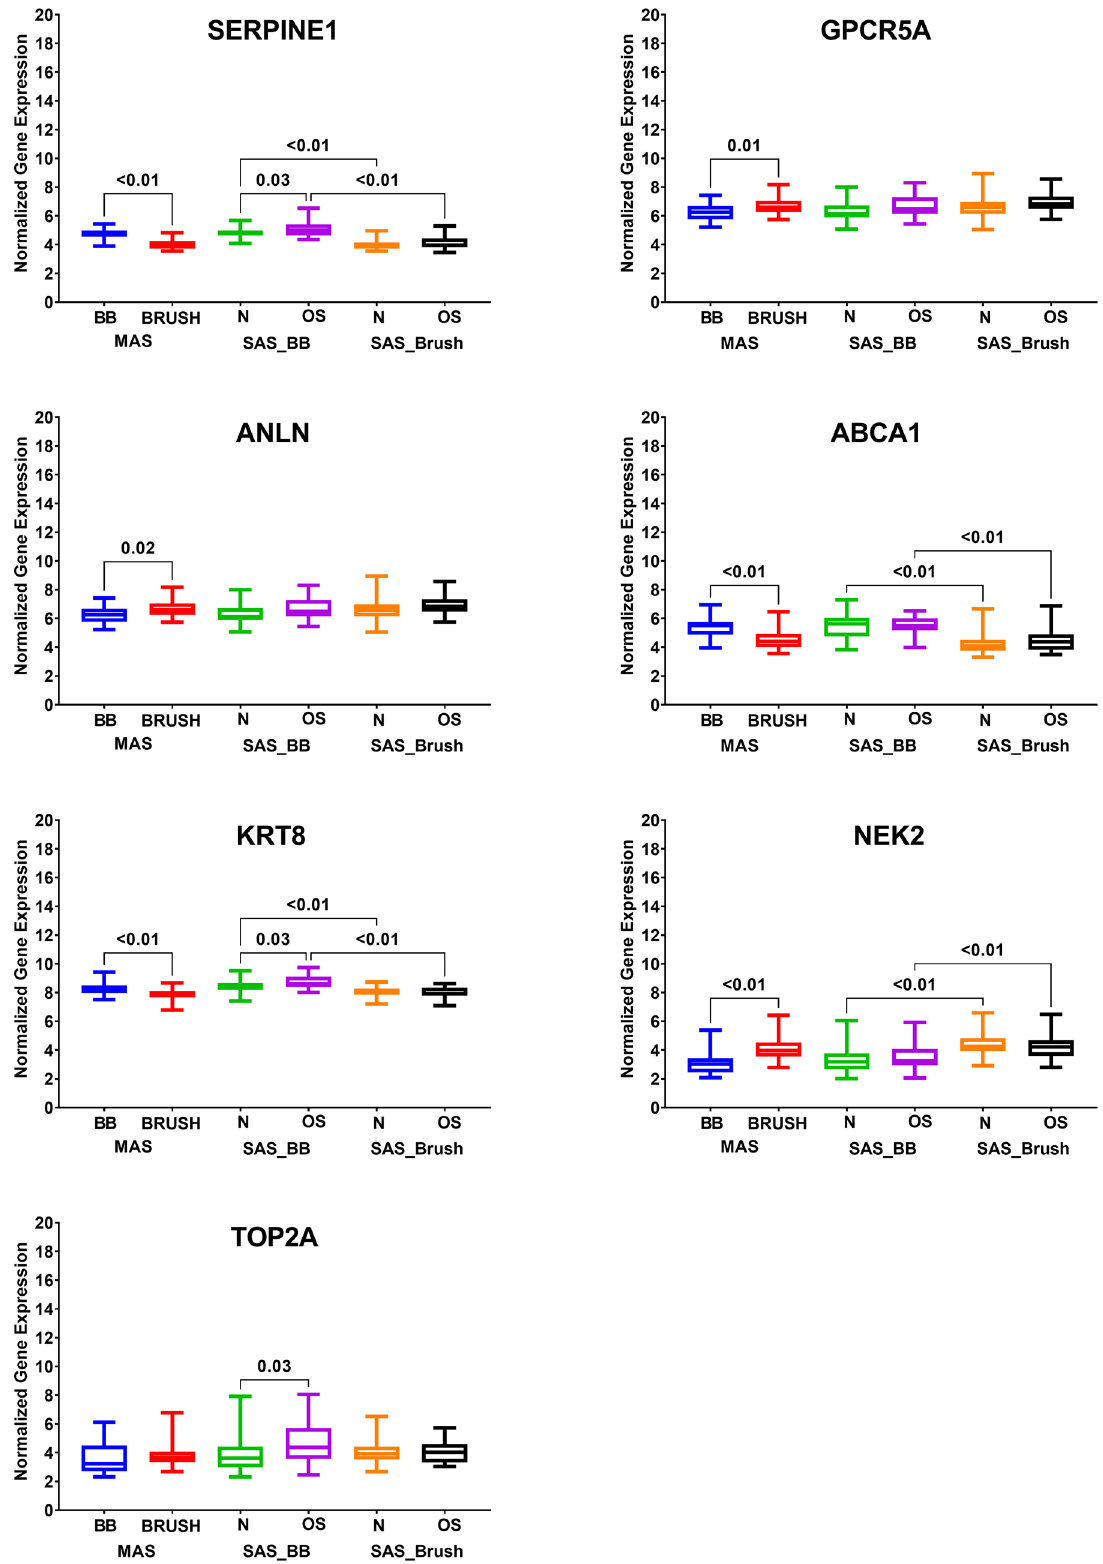
Figure 3. mRNA expression of the ten genes in bronchial epithelium using, GSE76227 transcriptomic dataset that contains the expression data of 190 bronchial biopsies (BB) and epithelial brushing (BRUSH) from Unbiased BIOmarkers in Prediction of REspiratory Disease outcomes (U-BIOPRED) Project. The normalized gene expression of each of the identified genes was extracted and compared between different subgroups. The datasets were subdivided into nonsevere asthmatic (MAS), severe asthmatics (SAS) (oral steroid naïve (N) vs. oral steroid users